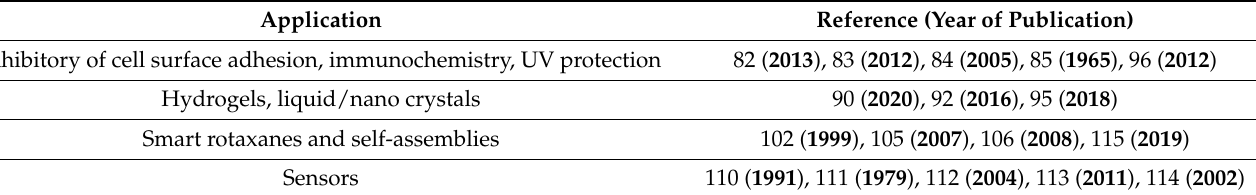
Table 3. Summary of the various applications for azo-guest or azo-grafted